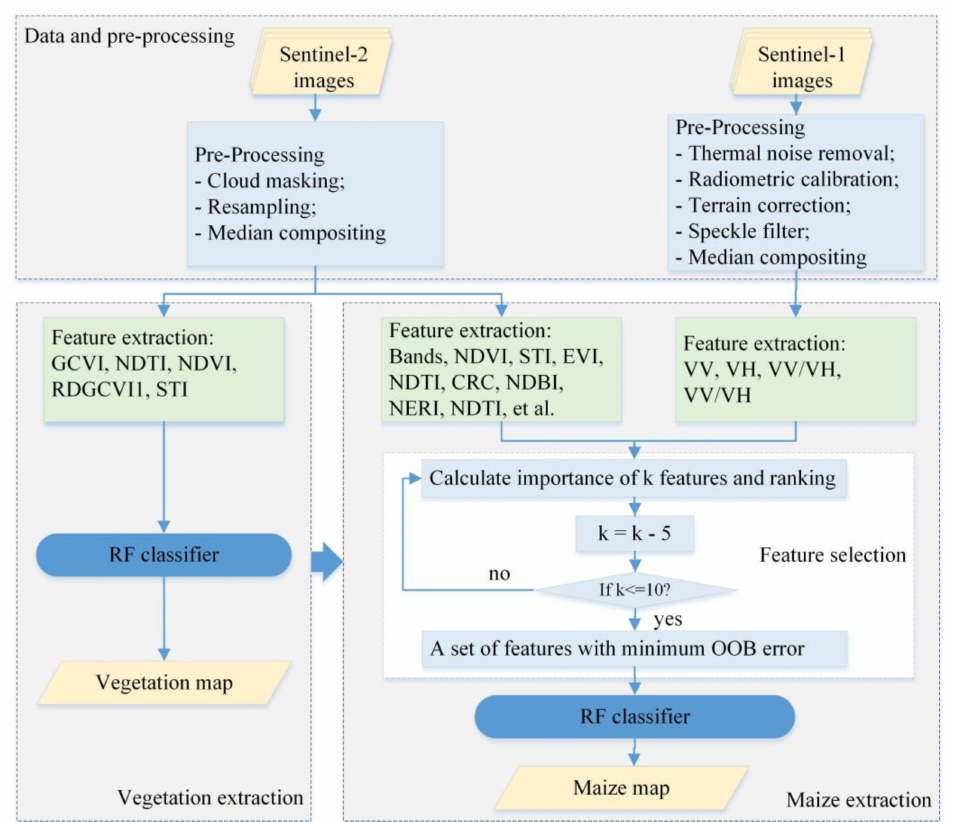
Figure 2. Technical flow of the maize planting area extraction scheme. “k = k − 5” represents the elimination of 5 smallest importance features in each iteration process. It includes three parts: (1) Data preparation and preprocessing; (2) Extraction of vegetation area using S2 images; (3) Extraction of corn planting area using S1(alone), S2(alone) and combined dataset,